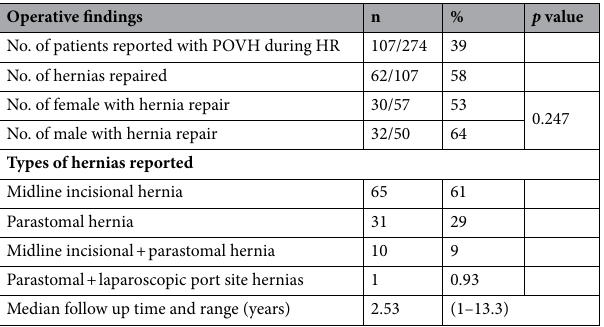
Table 2. Sub analysis of postoperative ventral hernia (POVH), following a Hartmann’s procedure (HP), outlining types of hernias percentage of hernia repair. POVH post operative ventral hernia, HP Hartmann’s procedure, HR Hartmann reversal, d days, y years.